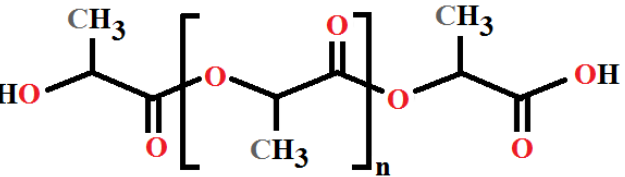
Figure 2. Chemical structure of poly (lactic acid), where n represents the number of chains.